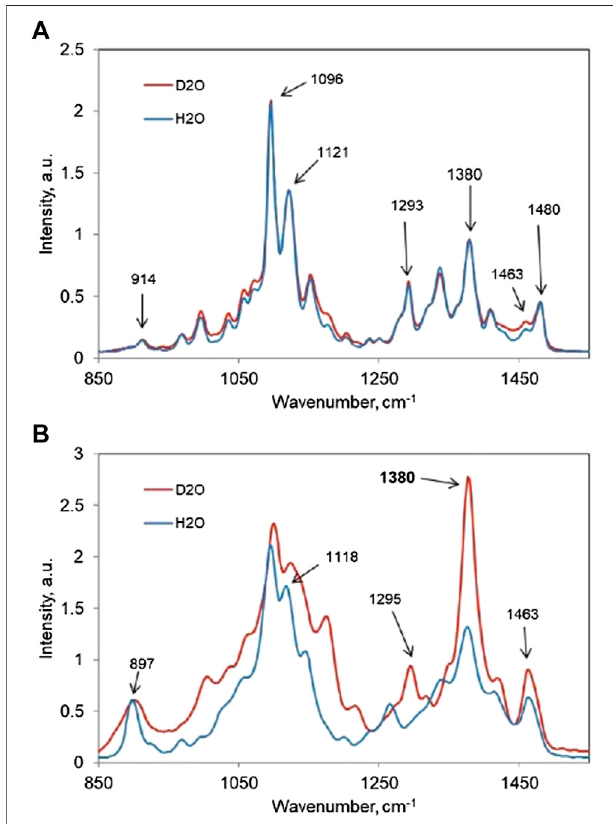
FIGURE 3 | In H 2 O and D 2 O Raman spectra, in 850- to 1,550-cm − 1 region, of (A) tunicin and (B) completely amorphous cellulose.